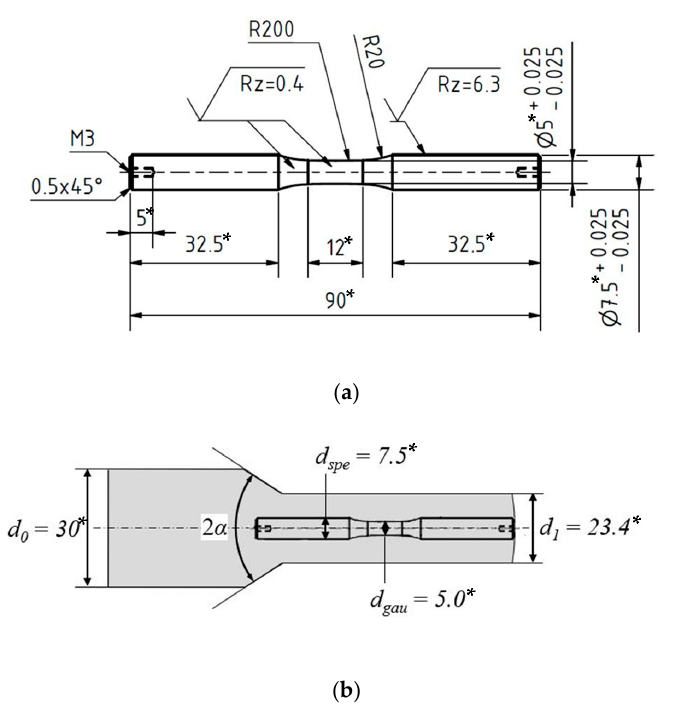
Figure 1. ( a ) Specimen for torsional fatigue testing; ( b ) Schematic visualization of extraction position. *All dimensions are in mm.